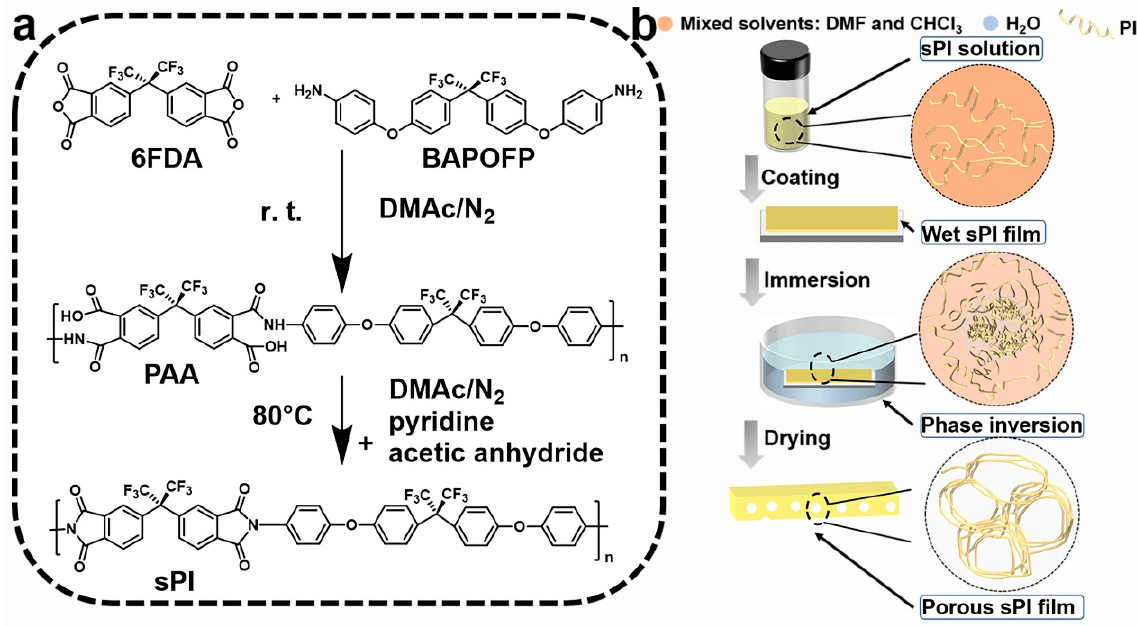
Figure 1. ( a ) Synthetic route for the soluble polyimide; ( b ) schematic illustration of a nonsolvent- induced phase separation approach for the fabrication of porous films.